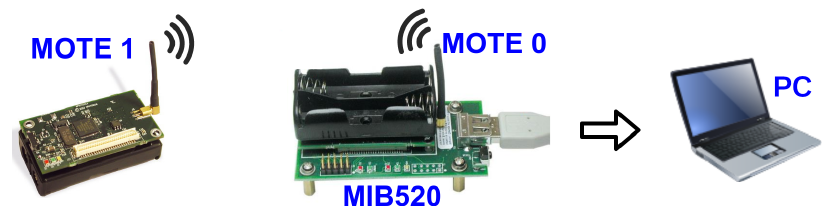
Figure 8. The adopted validation scenario: a first mote (Mote 0) is connected to the PC via wired serial communication; a second mote (Mote 1) is battery-powered and positioned away from Mote 0, with which communicates via the radio